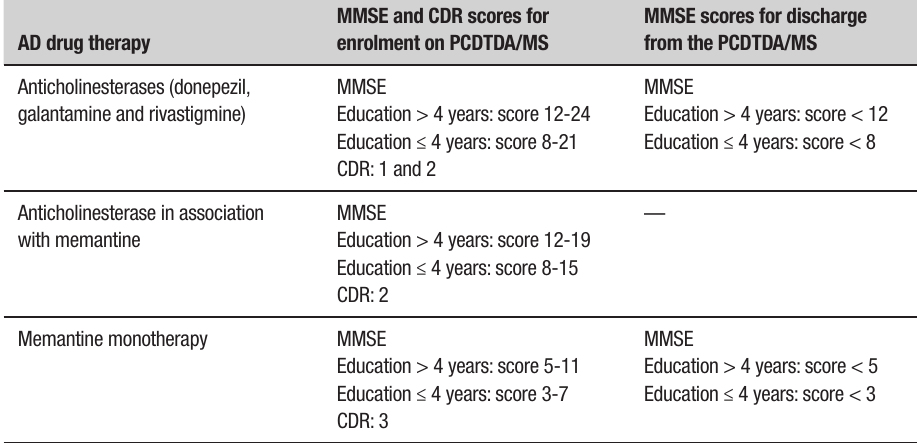
Table 1. Scores on MMSE and CDR screening tests for enrolment on and discharge from the Clinical Protocol and Therapeutic Guidelines for Alzheimer’s Disease